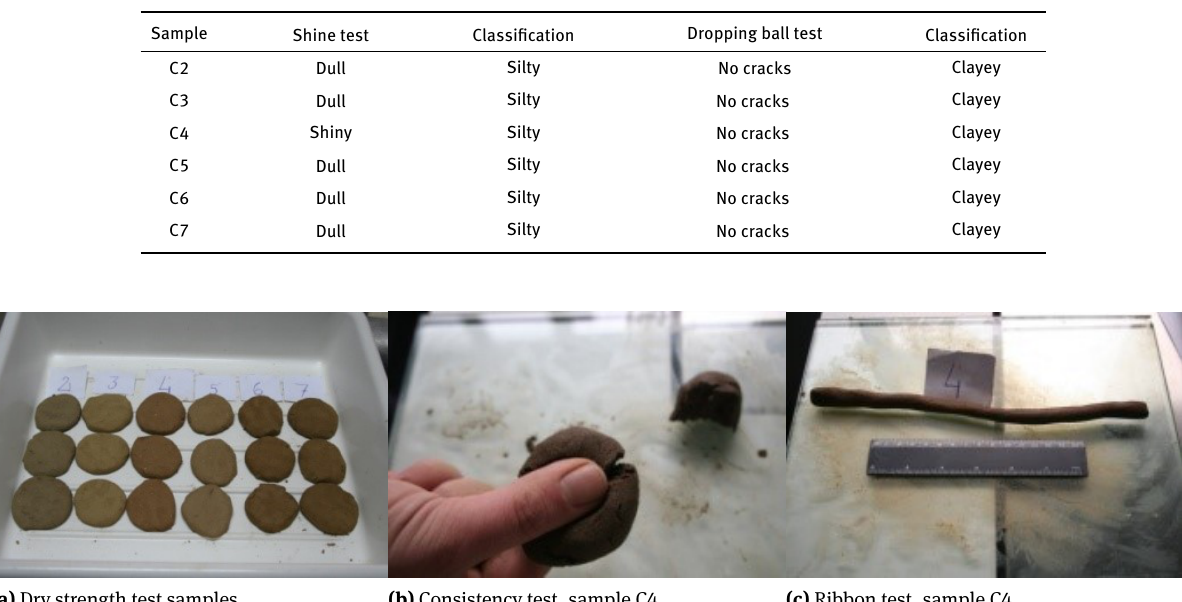
Figure 8: Dry strength, consistency and ribbon